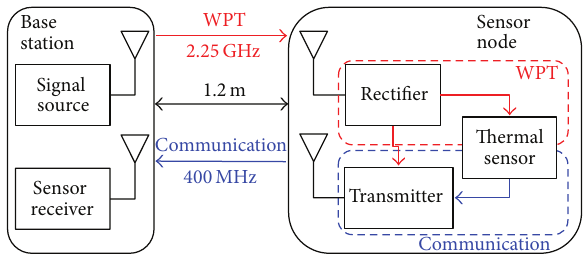
Figure 13: Block diagram of WiSEnT system using a wireless thermal